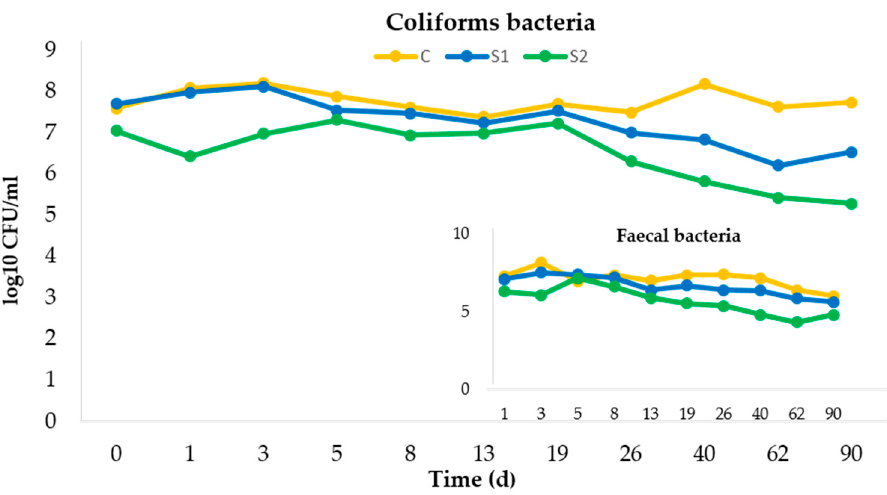
Figure 7. Counts of total coliforms and faecal coliform bacteria during composting. The initial counts of faecal coliforms in C, S1 and S2 reached 7.398, 7.146 log 10 and 6.806 log 10 CFU · mL − 1 , respectively. By the end of our investigation they declined to 5.991, 5.609 and 4.781 log 10 CFU · mL − 1 , respectively. The differences in the counts of faecal coliform bacteria between C and S2 piles were significant at the level of p < 0.001 and those between S1 and S2 at the level of p < 0.05. The differences between C and S1 were insignificant ( p > 0.05) throughout composting